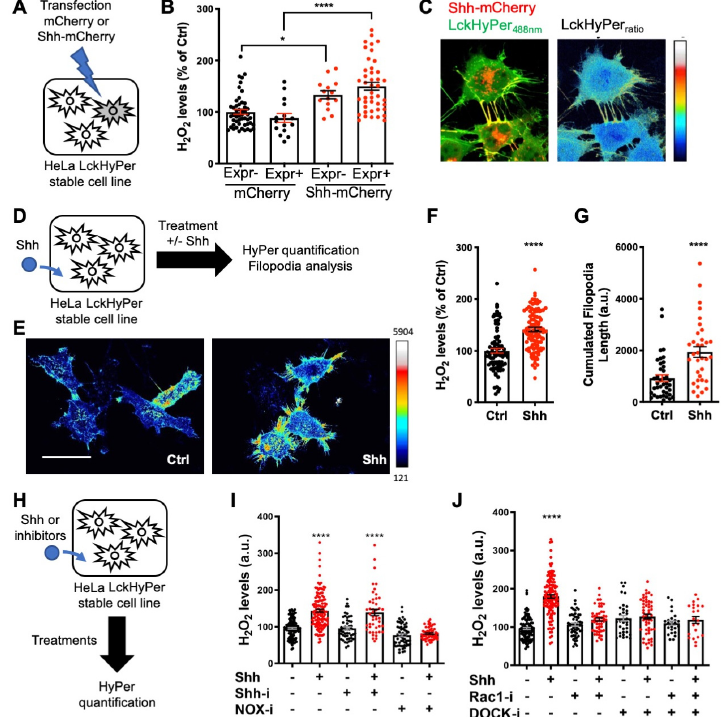
Figure 6. Shh regulates H 2 O 2 levels and filopodial growth. ( A , D , H ) Experimental procedures for the results shown in B–C ( A ), E–G ( D ) and I–J ( H ). ( A – J ) Cells stably expressing membrane-bound HyPer (LckHyPer) either transfected with constructs coding for Shh-mCherry ( A – C ) or mCherry ( B ), were ( D – G ) treated (Shh) or not (Ctrl) with Shh, or were ( H – J ) treated with various inhibitors. ( B ) H 2 O 2 was measured separately in cells expressing (Expr+) and non-expressing (Expr − ) the transfected construct, coding for either Shh-mCherry (right) or mCherry (left). H 2 O 2 levels in the non-expressing cells transfected with mCherry were taken as 100%. ( C ) Merging the red (Shh-mCherry) and green (Lck-Hyper 488nm ) signals highlights Shh-bearing filopodia (left), where H 2 O 2 levels are distinctly elevated (right). ( E – G ) Treated cells (Shh) display higher H 2 O 2 levels (imaged in ( E ), quantified in ( F )) and have longer filopodia (imaged in ( E ), quantified in ( G )) than untreated cells (Ctrl). ( I ) Cells treated (or not) with Shh were treated (or not) with either cyclopamine (Shh-i) or VAS2870 (NOX-i). ( J ) Cells treated (or not) with Shh were treated (or not) with either NSC23766 (Rac1-i) or CPYPP (DOCK-i) alone or in combination. In ( F ) and ( I , J ), untreated cells were taken as 100%. * p -value ≤ 0.05; ** p -value ≤ 0.01; *** p -value ≤ 0.001; and **** p -value ≤ 0.0001. Details on statistics in Methods. Scale bar: 50 μ m.